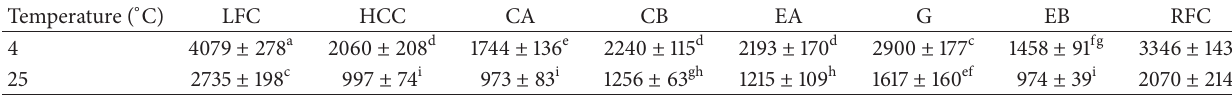
Table 2: Firmness of eight varieties of sliced cheese at different storage